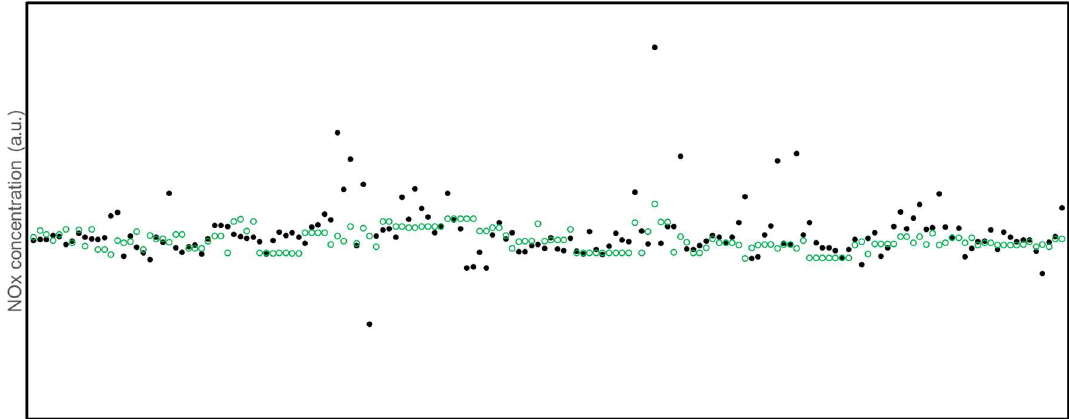
Figure 6. Relation between real-scale boiler NOx concentration and calculated NOx concentration.